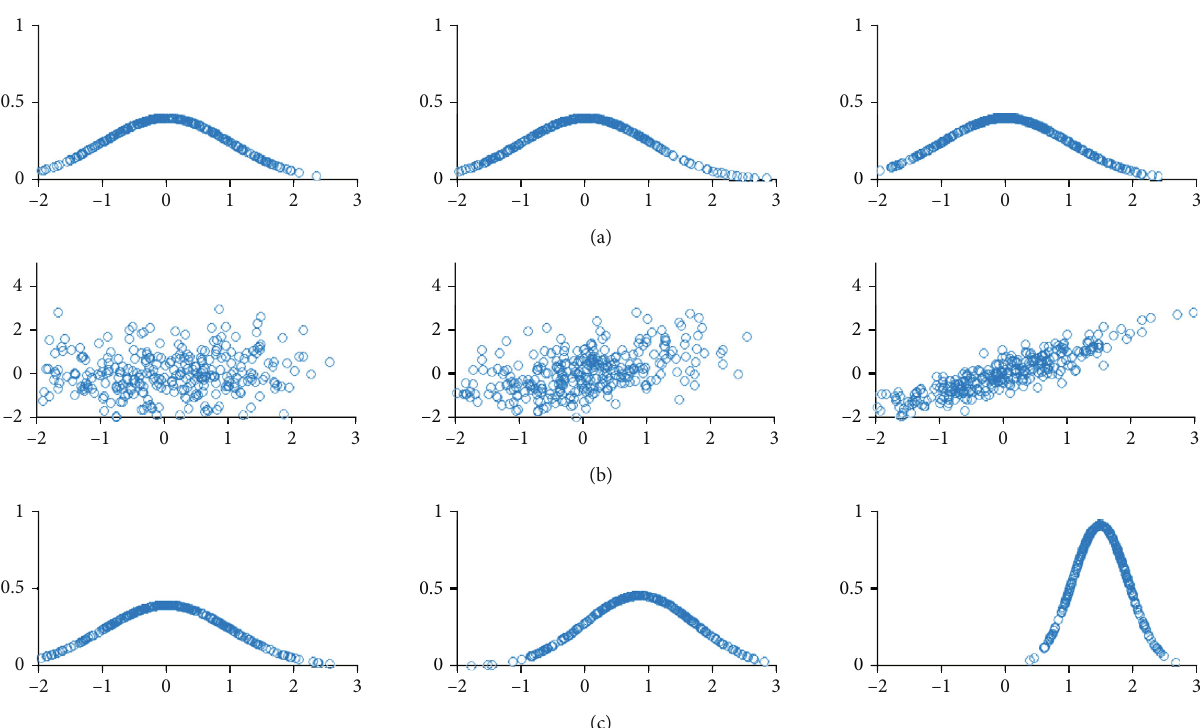
Figure 3: The simulated data of univariate (a) and of conditional (c) normal distributions; (b) displays the corresponding scatter plot of bivariate normal random